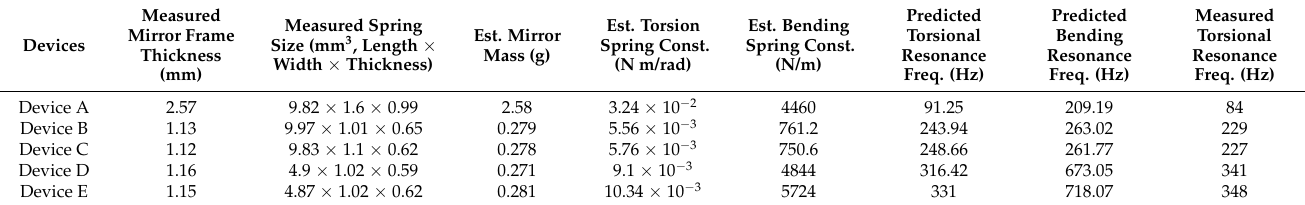
Table 3. Estimated and measured parameters of each device.